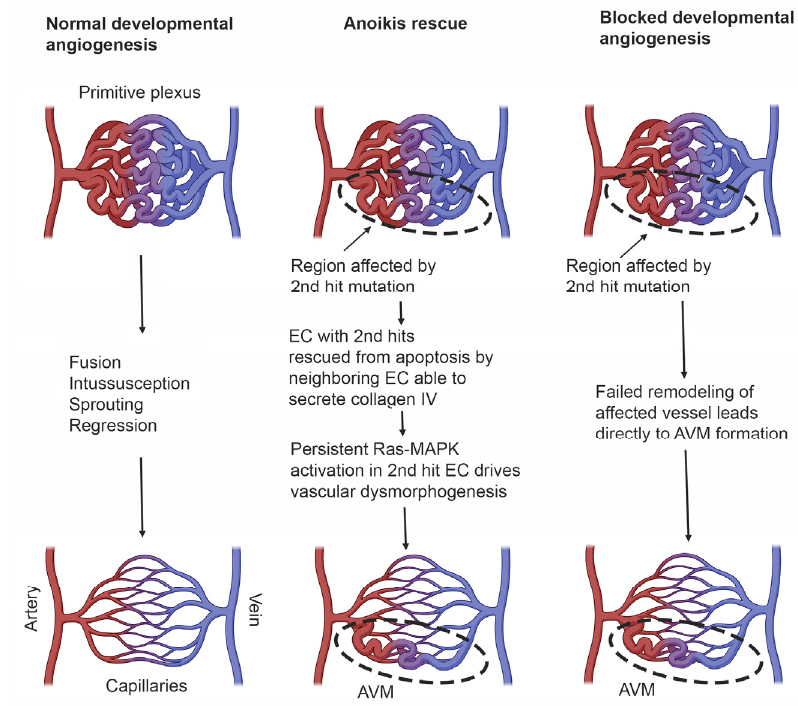
Figure 4. Models of AVM formation resulting from germline plus 2nd hit mutation in EPHB4 and RASA1 genes. See text for details.